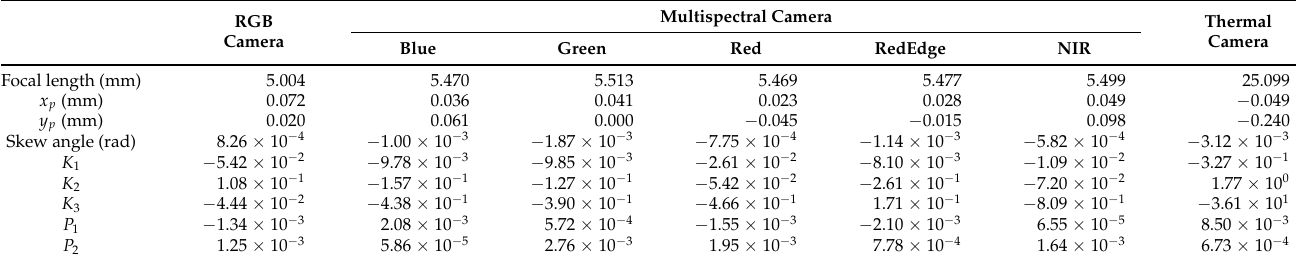
Table 2. Camera calibration parameters for the RGB, multispectral, and thermal